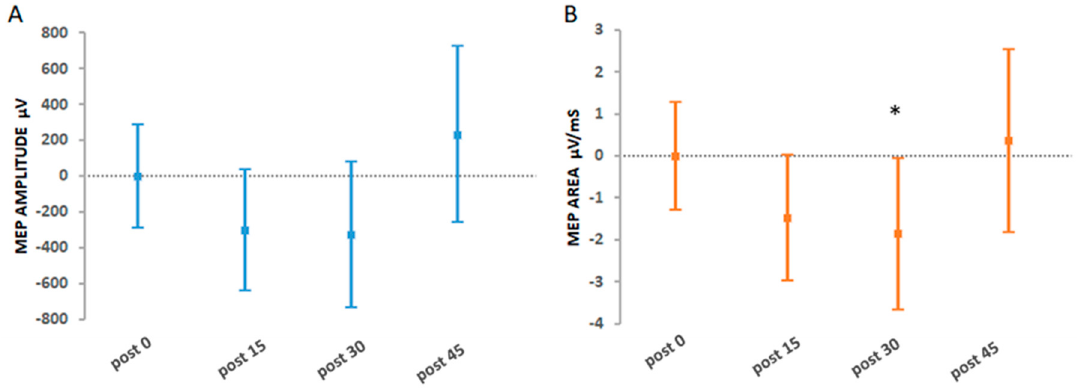
Figure 4. ( A ) MEP amplitude and ( B ) MEP area adjusted estimates for the primary analysis investigating super- or sub- additive effects for the Hi-Voluntary intervention at each post-intervention time-point. Error bars depict 95% CIs; * indicates significant effects ( p < 0.05).